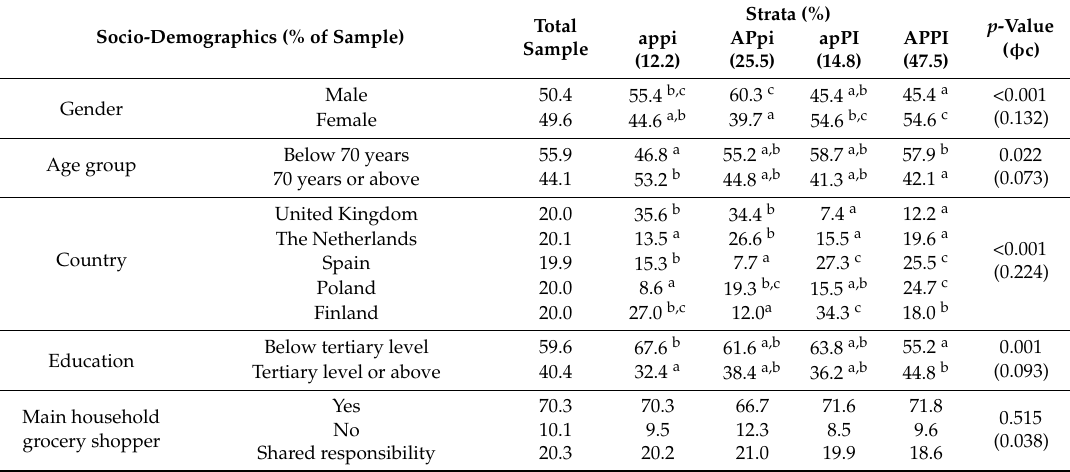
Table 2. Strata profiles based on socio-demographic characteristics in 1825 adults aged 65 years and older from five European